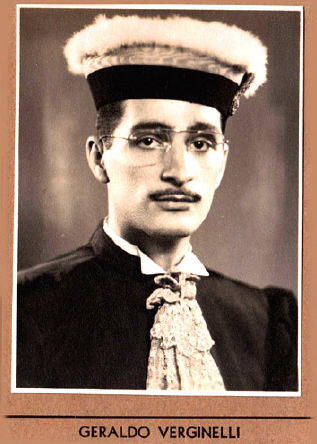
Fig. 1 - Geraldo Verginelli at his Graduation from USP Medical